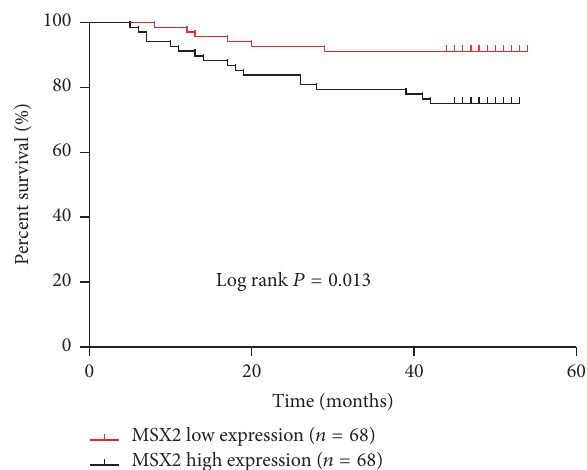
Figure 2: Kaplan-Meier survival analysis and log-rank test for overall survival of 136 CRC patients according to MSX2 mRNA expression level. Higher MSX2 expression predicated a shorter survival time (log rank, 𝑃 = 0.013 ). Red and black lines represent lower and higher MSX2 expression,